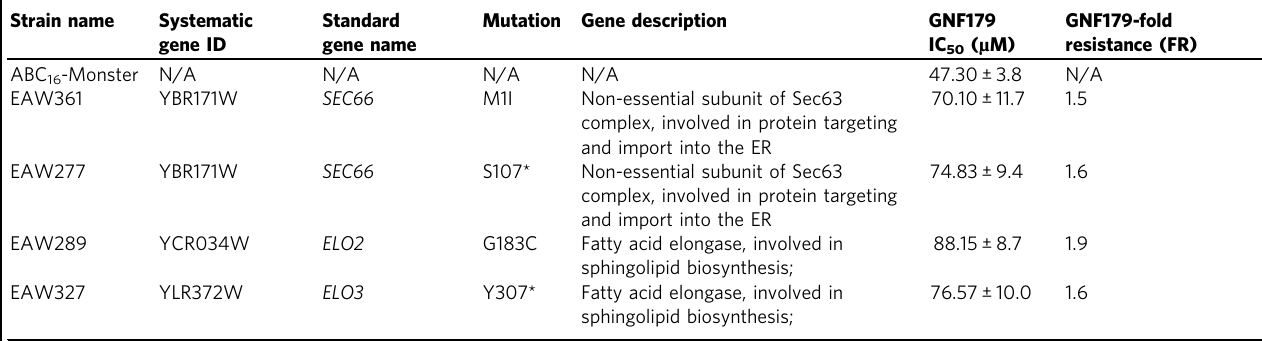
Table 2 IC 50s (mean and S.E.M) for GNF179 in the indicated yeast CRISPR- Cas9 edited